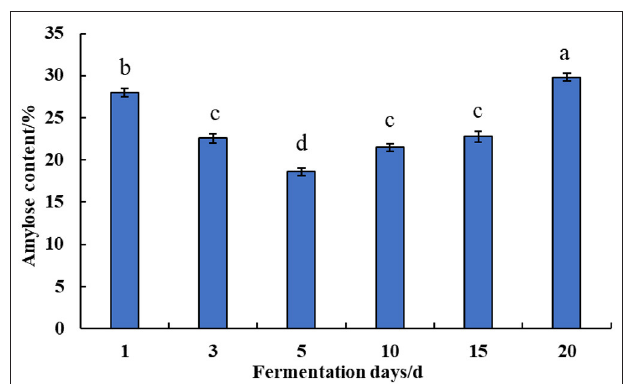
FIGURE 2 | Effect of natural fermentation on the content of amylose in corn ballast. The same letters in the figure do not differ in the student’s t -test with a significance level p <